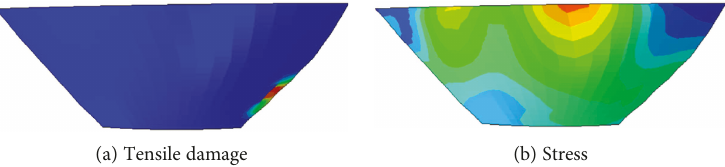
Figure 18: Dynamic response distribution of arch dam at t = 2 411 s .